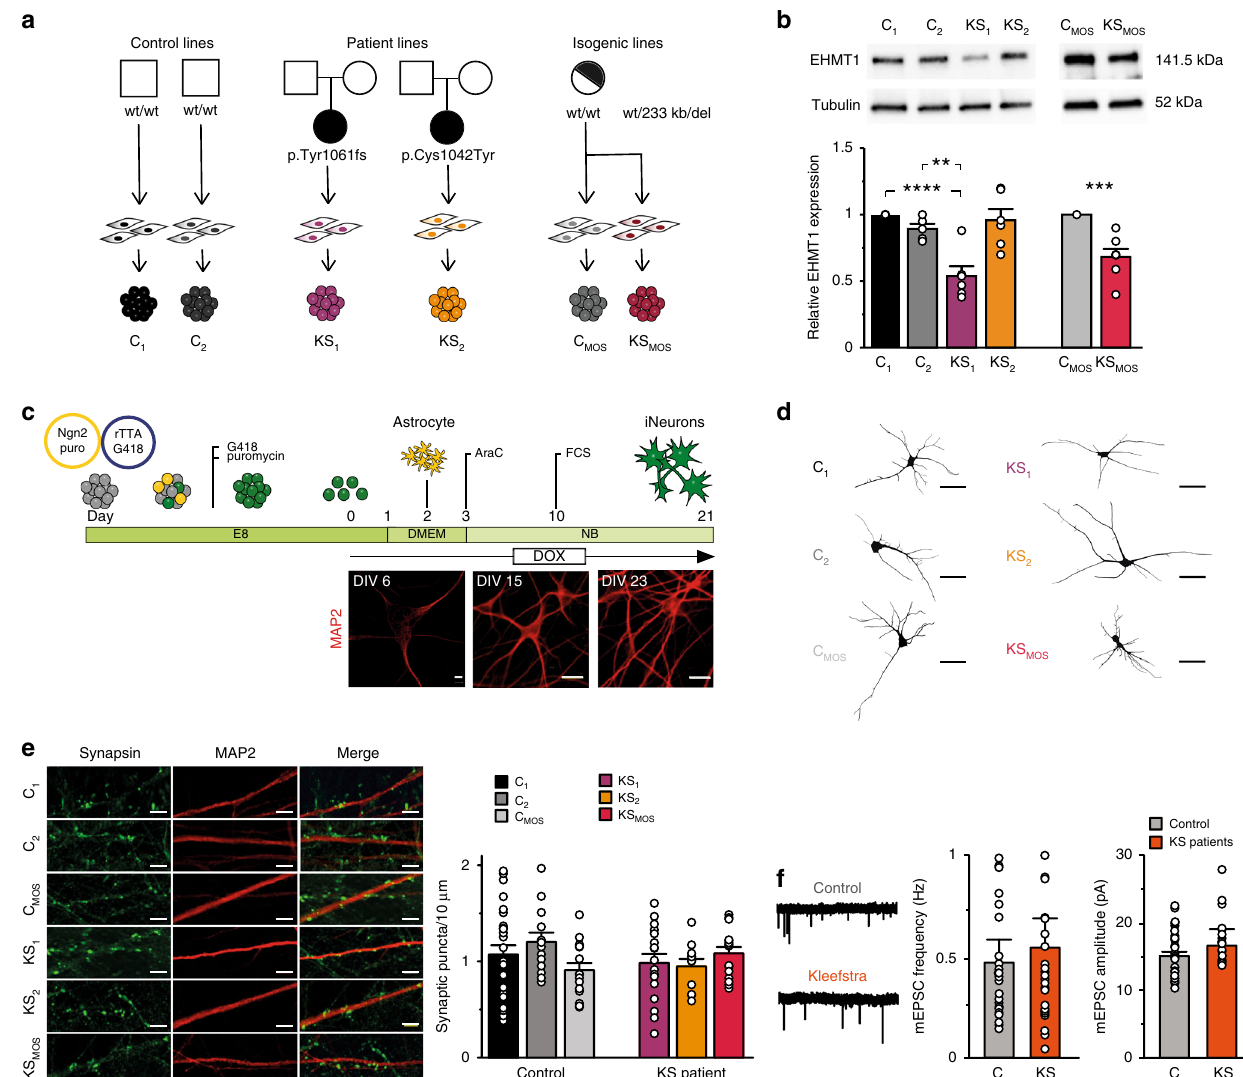
Fig. 1 Generation and characterization of iPS cell-derived neurons from KS patients. a KS and control iPS lines used in this study. b Western blot and quanti fi cation of EHMT1 protein levels in iPS cells, n = 6 – 7 for each condition. c Schematic presentation of the differentiation protocol, including representative images of control iNeurons immunostained for MAP2 during development (scale bar 10 µ m). d Representative somatodendritic reconstructions of control and KS iNeurons (scale bar 50 µ m). e Representative images of control and KS iNeurons stained for MAP2 (red) and synapsin 1/ 2 (green) at DIV 21 (scale bar 5 µ m) and quanti fi cation of synapsin puncta, n = 25 for C 1 ; n = 13 for C 2 ; n = 15 for C MOS ; n = 17 for KS 1 ; n = 11 for KS 2 ; n = 15 for KS MOS . f Representative example traces of mEPSCs from control and KS iNeurons at DIV 21. Quanti fi cation of the frequency and amplitude of mEPSCs in control (C 1 , C MOS , and C CRISPR ) and KS (KS 1 , KS MOS , and KS CRISPR ) iNeurons (i.e., pooled value for control and KS iNeurons), n = 30 for C, n = 29 for KS. Data represent means± SEM. ** P < 0.005, *** P < 0.0005, **** P < 0.0001, one-way ANOVA test and post hoc Bonferroni correction was performed between controls and KS iNeurons and Mann – Whitney test was performed between two groups. Source data is available as a Source Data fi the speci fi c lines KS2 and KS1, respectively. These differences were not observed between the isogenic lines (Supplementary Fig. 3J – N, Supplementary Data 1). Collectively, our data indicate that there were no signi fi cant differences between control and KS patient iNeurons with regard to neuronal morphology, excitatory synapses and intrinsic properties.